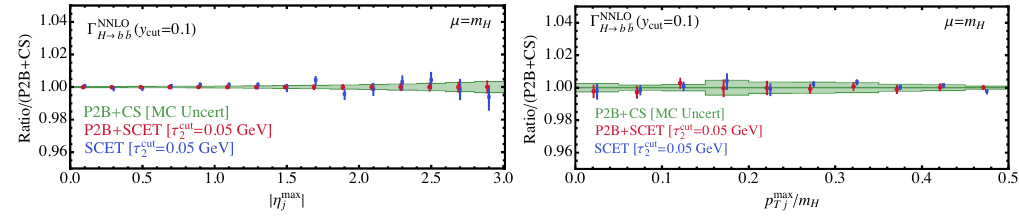
. The physical jet cut is set to y cut = 0 : 1. 2